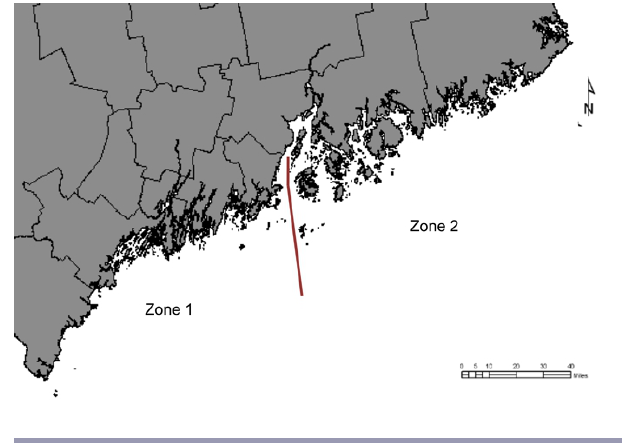
Fig. 4 . Map of the sea urchin co-management zones in